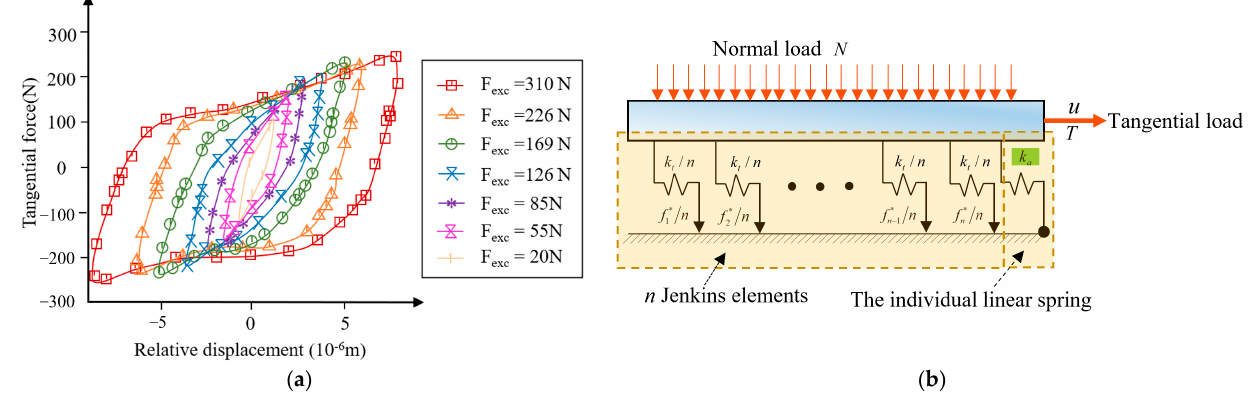
Figure 3. Modification of the classic Iwan model based on experiments: ( a ) experimental hysteresis loops, ( b ) the modified model.